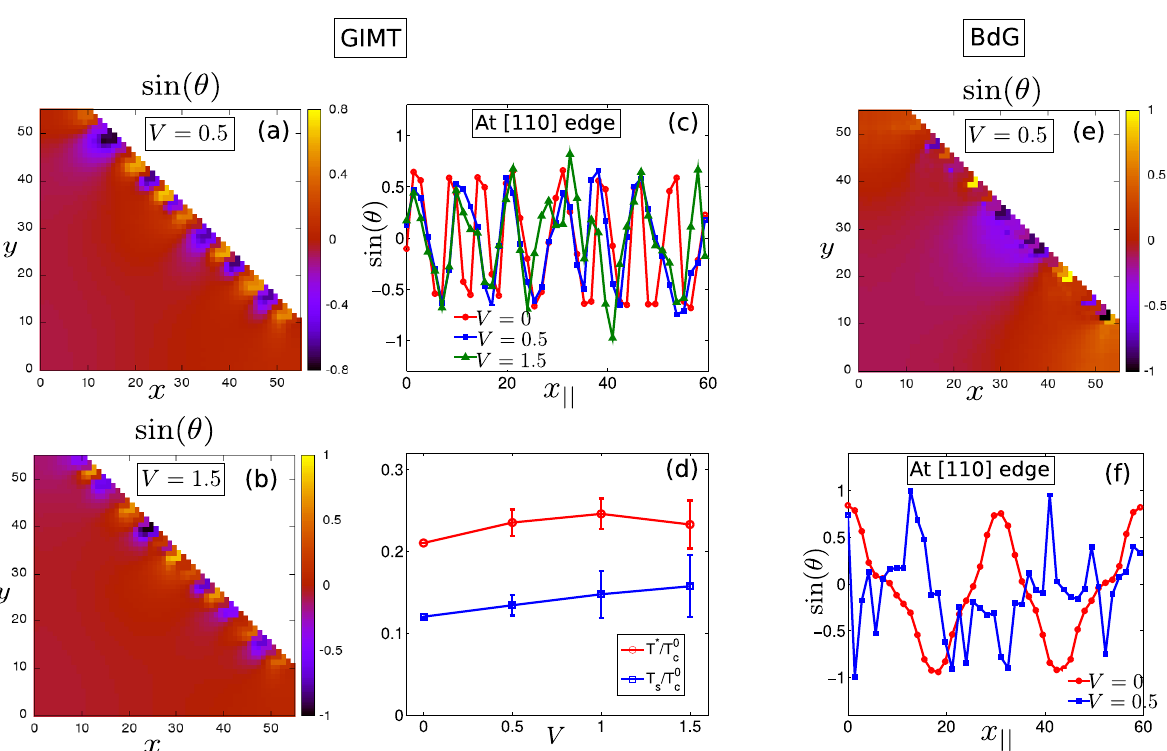
Fig. 4 Phase crystals for disordered sample. Color density maps of sin ð θ Þ in both GIMT ( a , b ) and BdG ( e ) for T = 0.32 T * < T s . Line plots of the phase modulations along the pair breaking [110] edge as a function of x ∥ are shown for GIMT ( c ) and BdG ( f ) for different disorder strengths V . The phase crystal is stable even in the presence of strong disorder within GIMT but does not survive even moderately weak disorder if strong correlation effects are not included. Phase crystal transition temperature T * and extended s -wave transition temperature T s are shown in ( d ), averaged over fi ve disorder con fi gurations, both scaled by the V = 0 superconducting transition temperature T 0 standard deviation about the mean disorder averaged